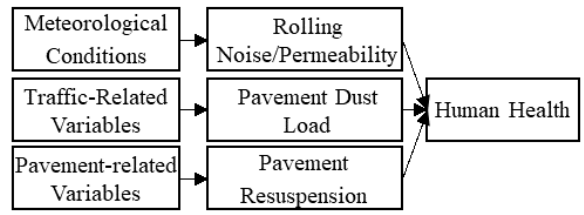
Figure 2: Variables that affect human